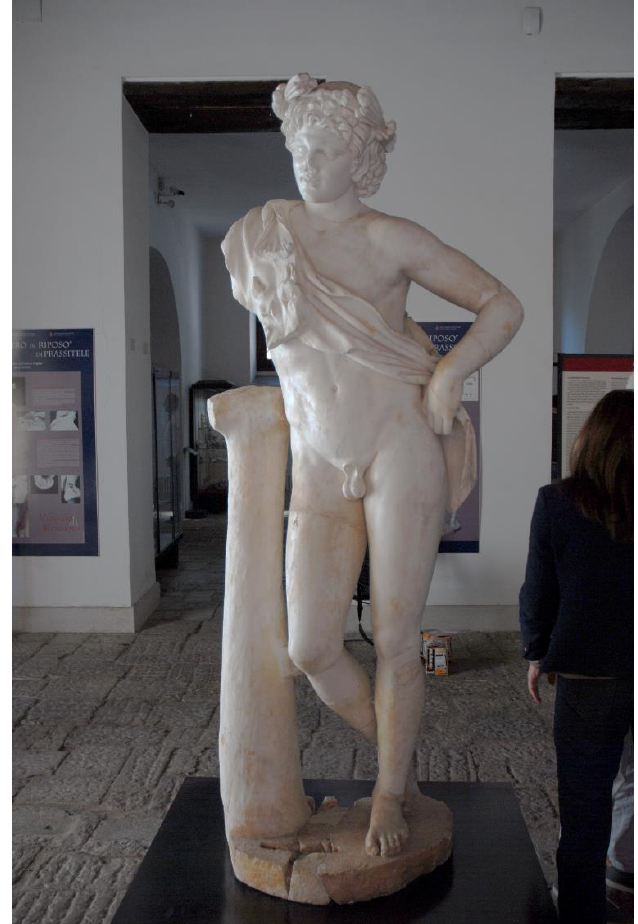
Figure 3. The Resting Satyr , Archaeological Museum of the Ancient Capua.